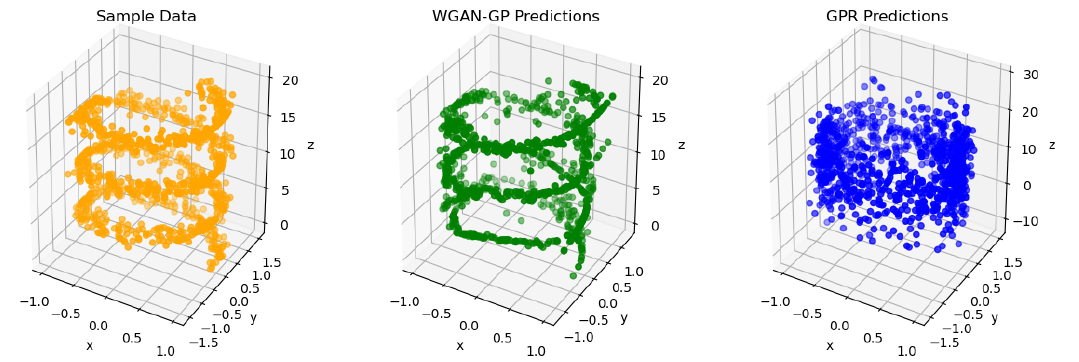
Figure 11. The helix dataset. The test data is shown on the left, sampled points from the WGAN are shown in the middle and sampled points from the GPR posterior are shown on the right.